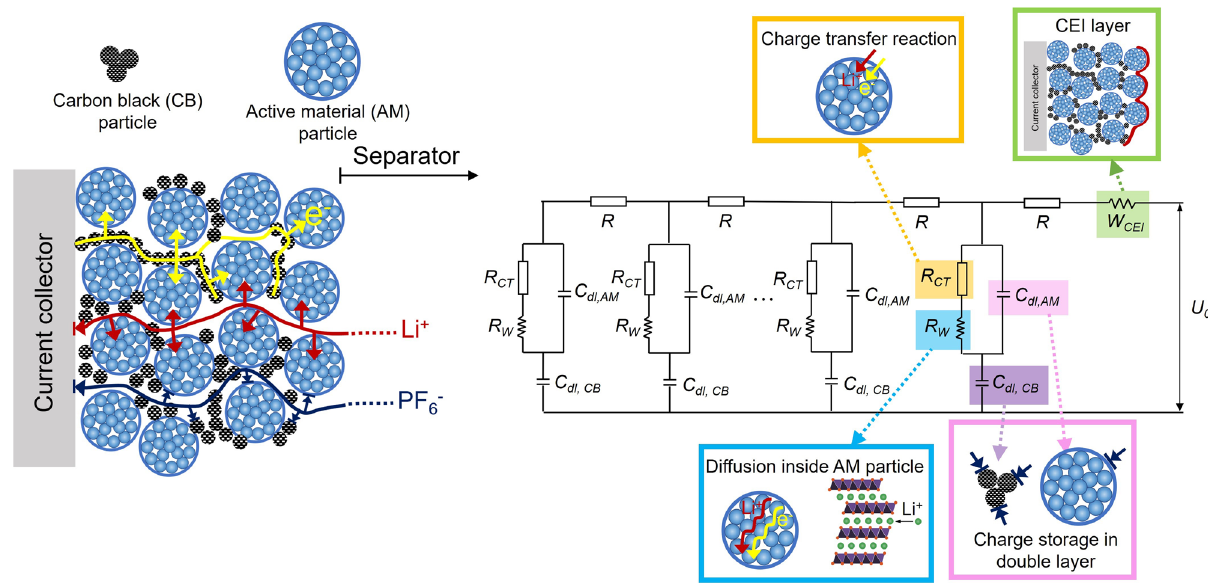
Fig. 3 Illustration of all possible physical and electrochemical processes in a cathode of LIB and a transmission line equivalent circuit and corresponding electrochemical processes. This fi gure shows how the physical and electrochemical processes can be represented in a transmission line model. For example, a charge transfer process at the interface of active material particles can be represented by a resistor ( R CT ), Li diffusion processes inside active material and through CEI can be represented by Warburg resistors, R w and R CEI . The CEI stands for possible surface interface on a cathode; R s are resistor; C dl s are double-layer capacitor and U 0 is applied voltage.